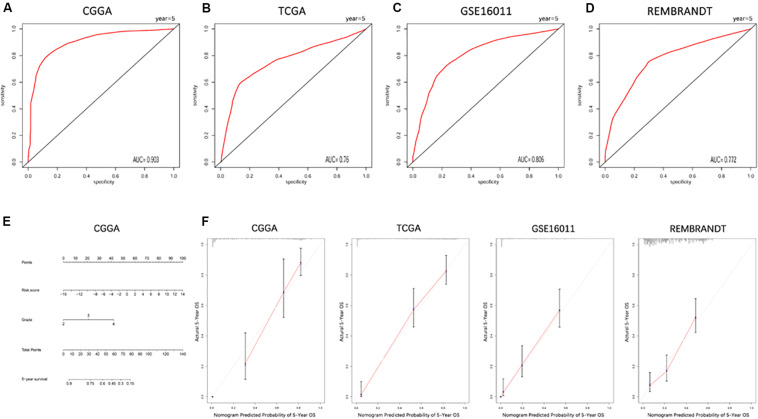
ROC curves and a nomogram of the signature of 19 ferroptosis-related genes predicting survival in glioma patients. (A–D) ROC curves showing the sensitivity and specificity of predicting 5-year survival with the ferroptosis-related gene signature in CGGA (A), TCGA (B), GSE16011 (C), and REMBRANDT (D) datasets. (E) A nomogram for predicting 5-year cancer-specific survival in the CGGA dataset. (F) Calibration curves for the nomogram predicting 5-year survival in glioma patients in the CGGA, TCGA, GSE16011, and REMBRANDT datasets.